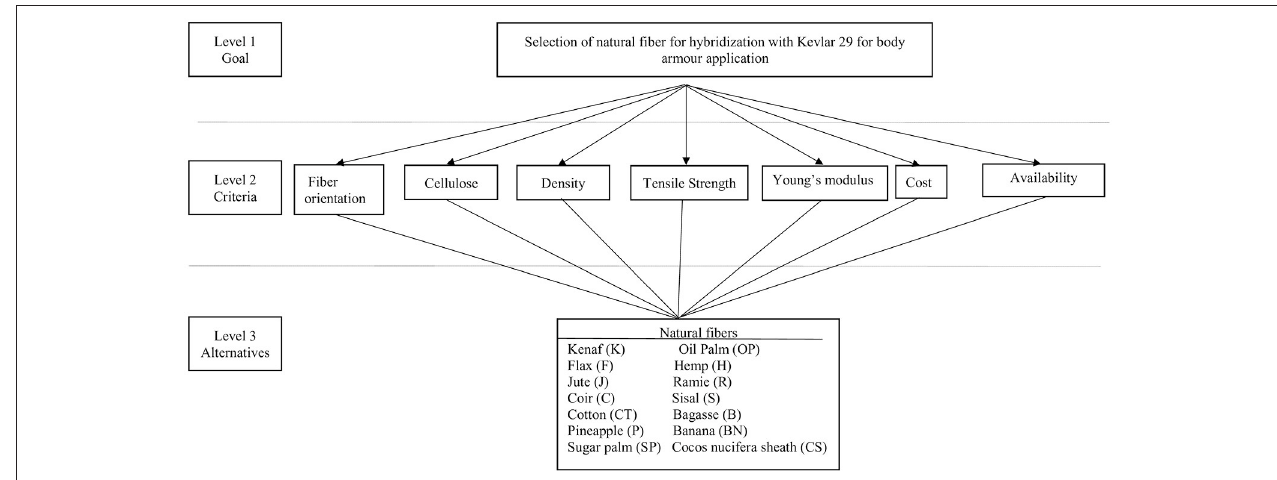
FIGURE 3 | Hierarchical framework for the selection of natural fiber.